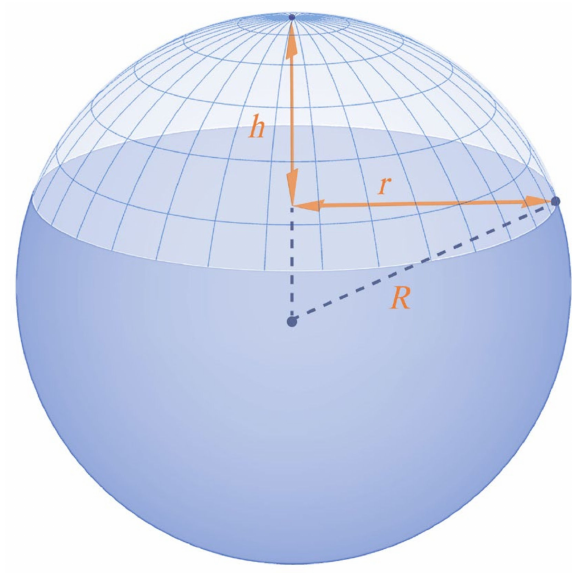
Figure 3. Diagram of particle number